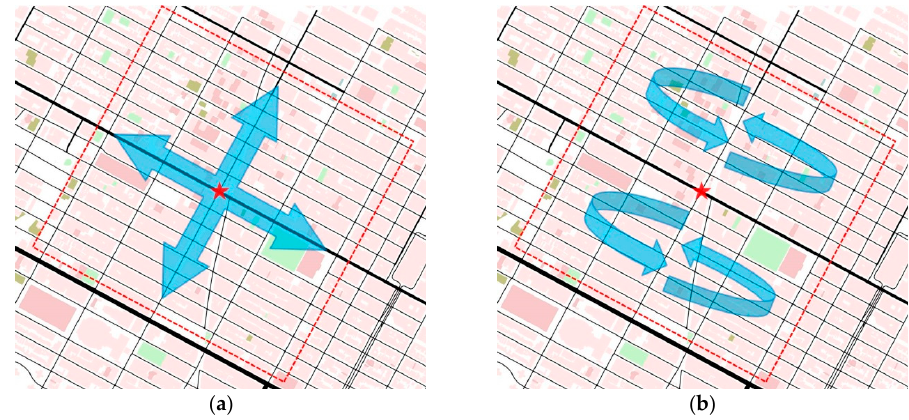
Figure 9. Traffic routes in the Manhattan scenario. ( a ) Traffic route 1 (uniform); ( b ) Traffic route 2 (deviated); Traffic routes are indicated by arrows in urban scenarios; The red start is the source node that periodically broadcasts data messages; The red broken line indicates the boundary of ROI.